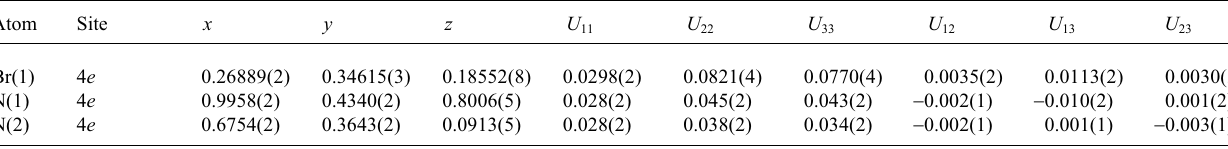
Table 3. Atomic coordinates and displacement parameters (in Å 2